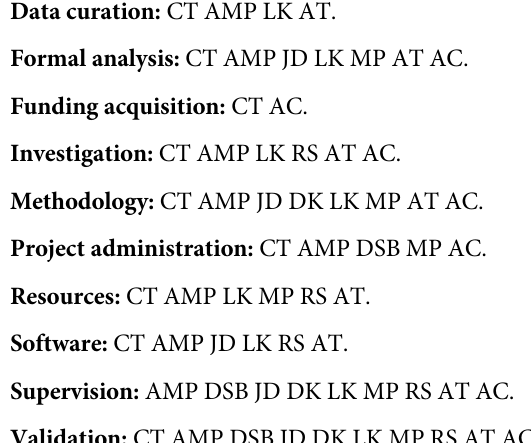
S1 Table. Associations of individual HoNOS items and the Total HoNOS score with inpa- tient admission and ‘regular’ vs ‘high’ community mental health service